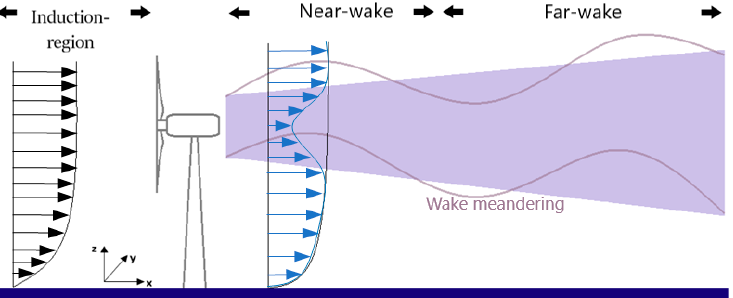
Figure 1. Schematic representation of the three wake regions and of the wake meandering phenomenon, which is indicated by the curved lines. The wind profiles upstream (in black) and downstream (in blue) from the turbine are shown.